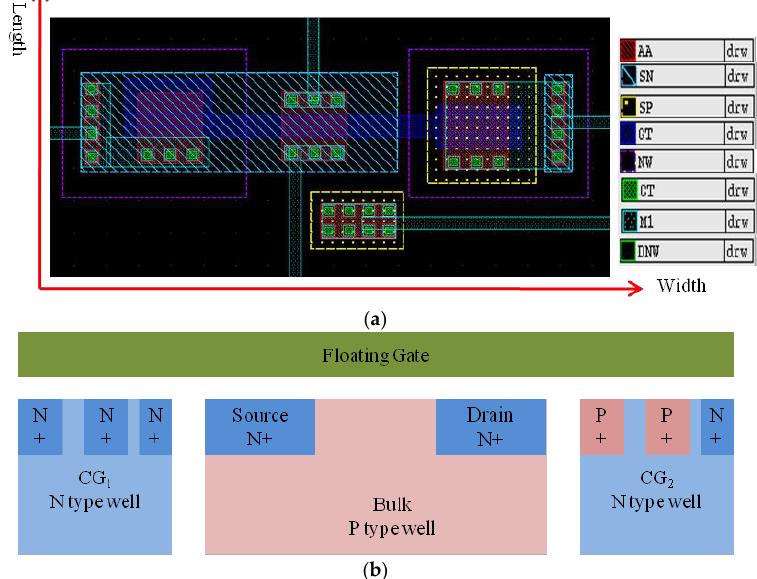
Figure 4. ( a ) Layout of the proposed ANC device, where AA is the active area, SN is the N + implantation for the source and drain, SP is the P + implantation, GT is the polysilicon gate, NW is the N-type well, DNW is the deep N-type well, CT is the contact area, and M1 is the metal one. ( b ) Cross section of the layout, where CG 1 is a N-MOSC and CG 2 is a P-MOSFET with a common source, drain, and